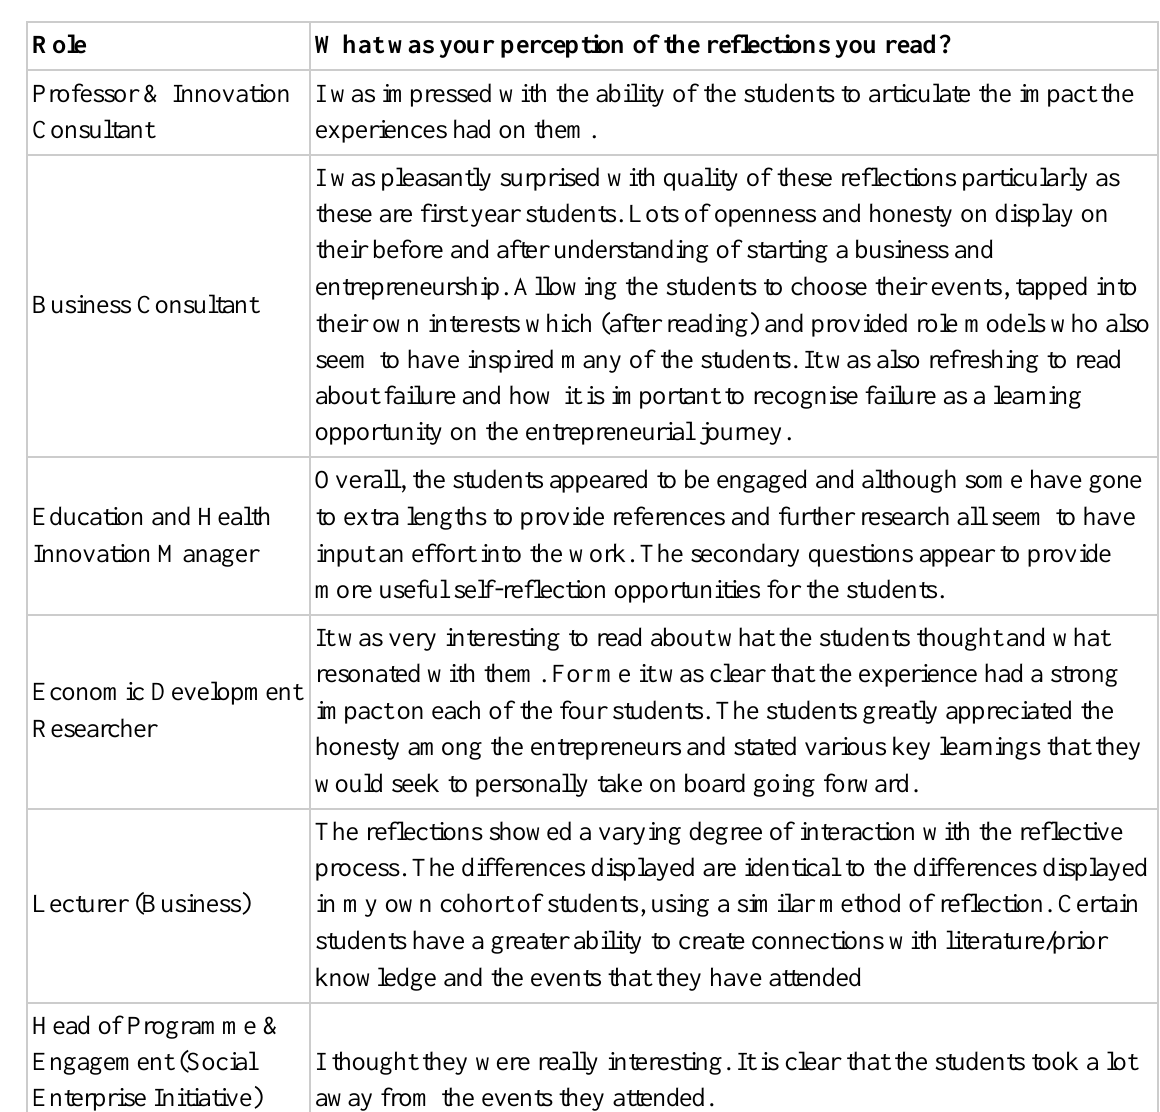
Table 1: Expert Perceptions of Student Reflections Next, reviewers were asked to provide their thoughts on the importance of industry to the enterprise student (See Table 2). Many referred to the value that students obtain in connecting with the real-world context of the entrepreneur, or a live business project, providing them with the opportunity to develop practical skills for the workplace. Three of the review panel also noted that it is advantageous for industry to connect with students also, to gain insight about this generation and their